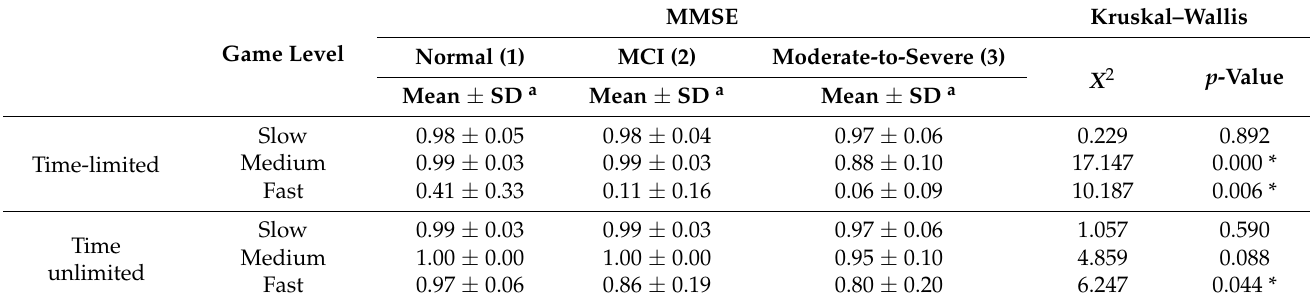
Table 4. Posterior comparisons of the different groups by test scores using Kruskal–Wallis.